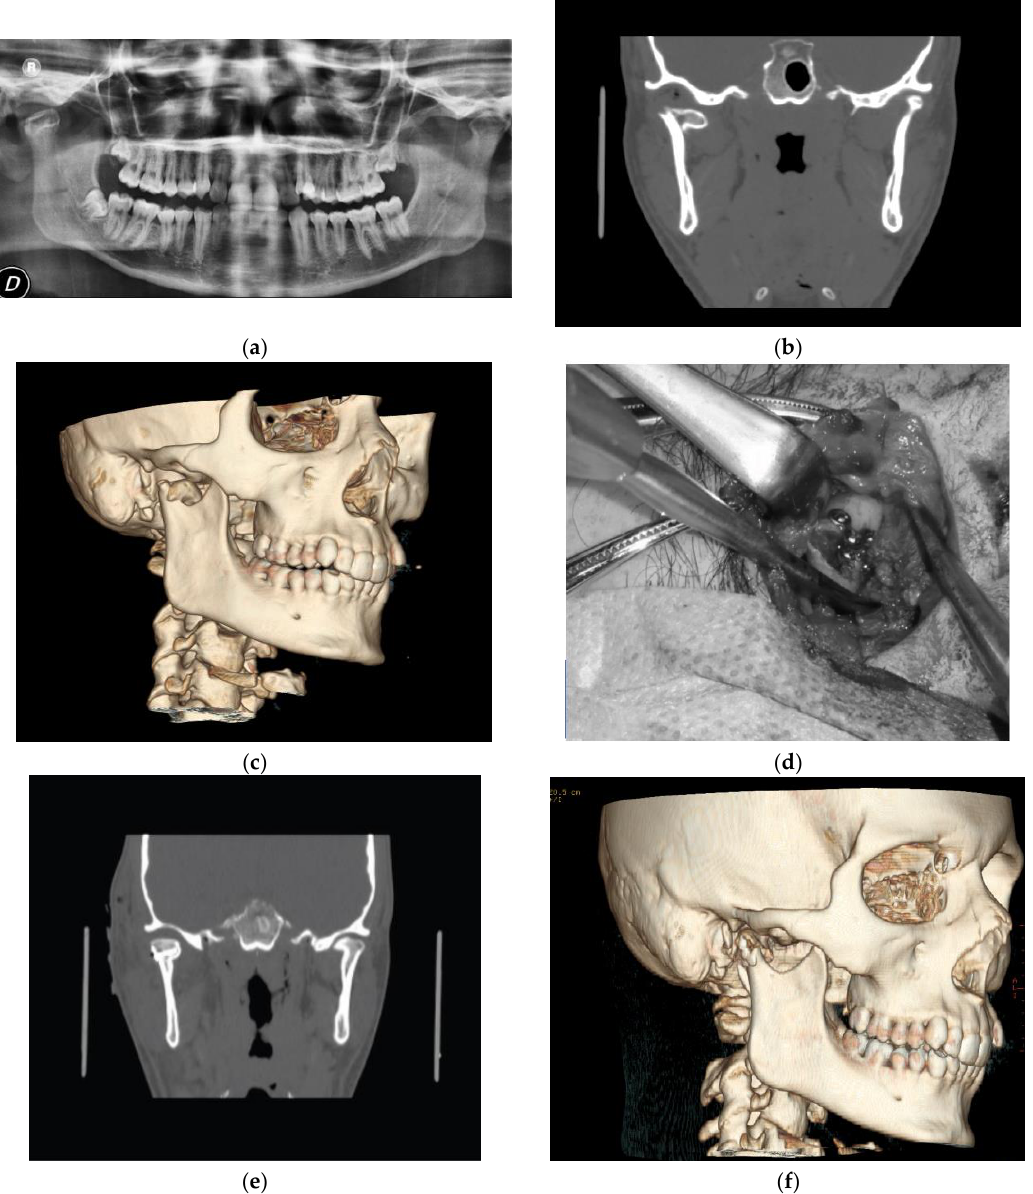
Figure 1. ( a ) Pre-operatory panoramic X-ray; ( b ) pre-operatory computerized tomography scan (CT scan); ( c ) pre-operatory volumetric CT scan; ( d ) intra-operatory view; ( e ) post-operatory coronal CT scan; and ( f ) post-operatory volumetric CT scan of patient #1.